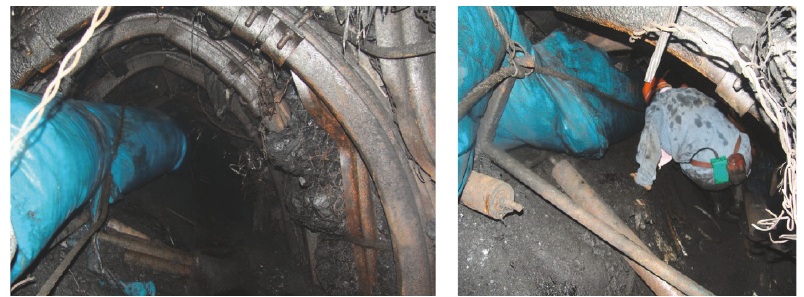
Figure 8: Damage of 1410 tailgate.